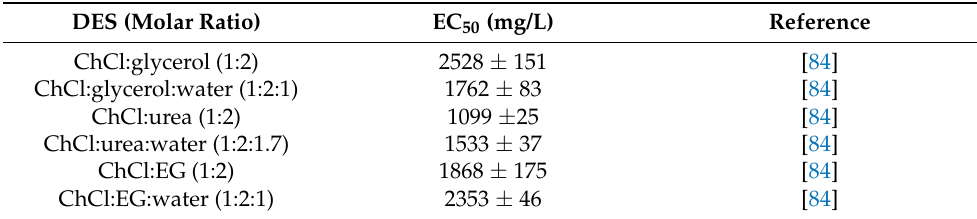
Table 4. Ecotoxicological data of some DESs in D. magna